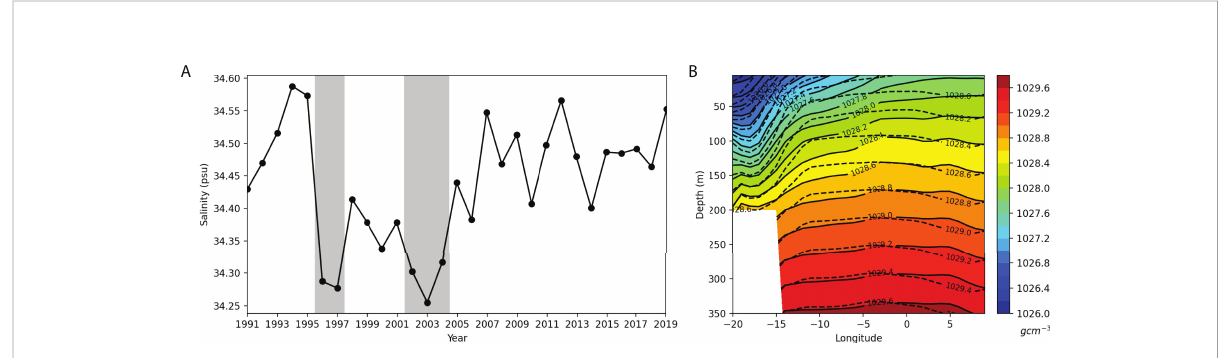
FIGURE 15 (A) Near-surface salinity within Greenland Sea Gyre (GSG) and (B) cross section of potential density structure between 74-76°N of 1994 (dashed line) and 2003 (solid line). The grey backgrounds denote the two low salinity periods in the